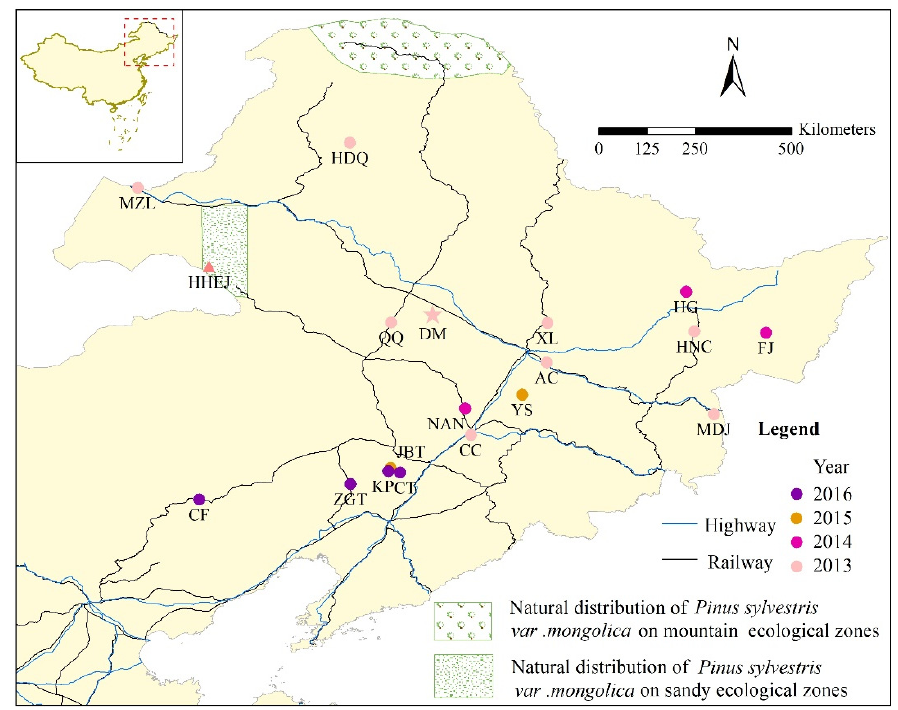
Figure 1. Sampled Chinese S. noctilio population locations (indicated by 2–4 letter combinations) and year of the first detection; natural distribution area of the host. The triangular marker for HHEJ indicates the Honghuaerji Scenic Area. The pentagram marker for DM indicates the place where S. noctilio was first detected in China.